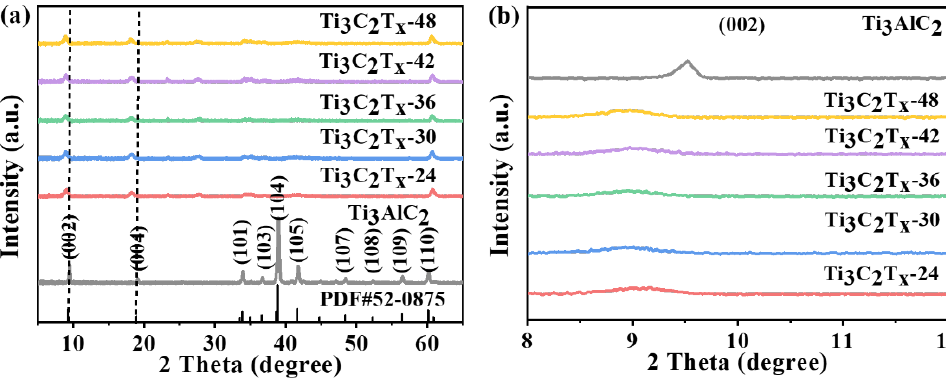
Figure 1. ( a ) XRD pattern and ( b ) (002) peak of Ti 3 AlC 2 , Ti 3 C 2 T x -y nanosheets (y = 24, 30, 36, 42 and 48). Figure 2 showed SEM images for Ti 3 C 2 T x samples with different etching time (24 h, 30 h, 36 h, 42 h and 48 h). Ti 3 C 2 T x samples show the obvious morphological features of layered structure with broadened interlayer spacing. It can be observed that Ti 3 C 2 T x -36 shows uniform layers and a smooth surface. However, the Ti 3 C 2 T x -42 and Ti 3 C 2 T x -48 tended to aggregate and stack again with the increasing etching time. It is well accepted that the catalysis generally occurs on the active sites, while the active sites mostly exist in the edges, unsaturated steps, terraces, kinks, and/or corner atoms for layered structures [3,18]. The catalysts’ surface holds a spot of active sites. The stacking, layered structure may cause the less active sites’ exposure. Ti 3 C 2 T x -36 shows a uniform layered structure (Figure S2a). Elemental mapping spectra presented Ti, C and O elements in Figure S2b,d. Oxygen-containing functional groups are decorated on the surface. The atomic structure of Ti 3 C 2 T x nanosheets is shown in Figure S2e. The side view for Ti 3 C 2 T x nanosheets shows a broadening layered structure (Figure S2f). TG analysis was conducted to inspect ther- mostability in Figure S3. Ti 3 C 2 T x nanosheets decorated with oxygen-containing functional groups shows the interbedded self-supporting structure, which also preserves morphologi- cal stability. Specifically, Ti 3 C 2 T x -36 showed the best thermostability among all Ti 3 C 2 T